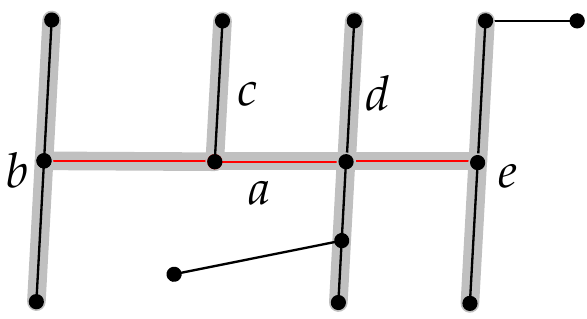
Figure 3. Spatial scene of the stroke a (red).